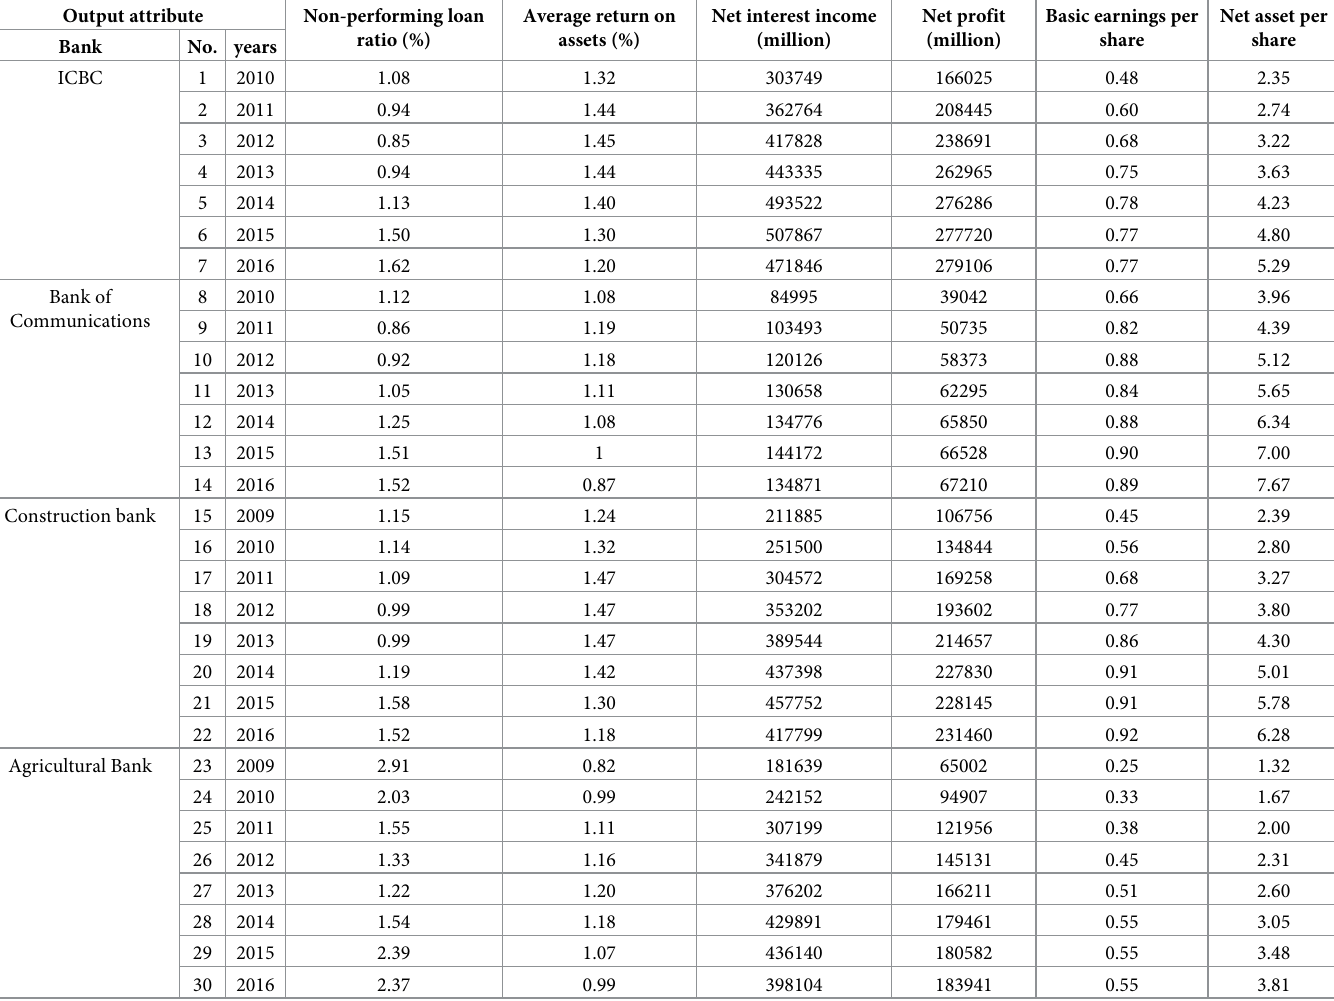
Table 1. Sample data table of metrology attributes for management efficiency of commercial banks.